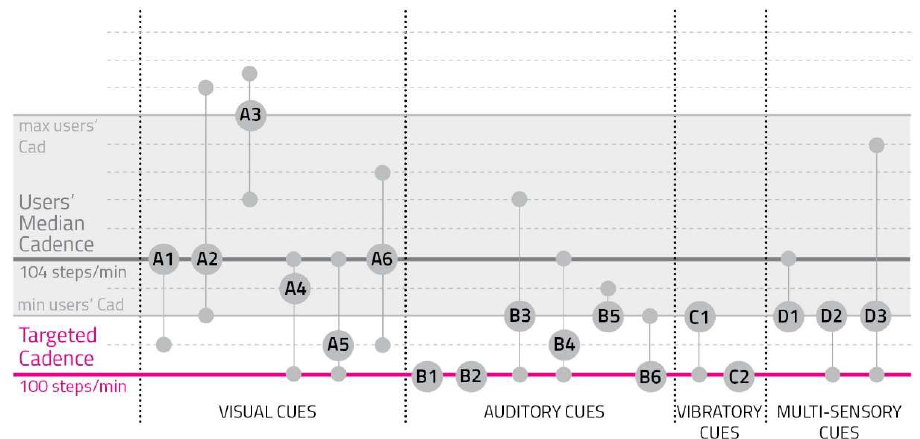
Figure 4. Users’ cadence during each signal. The gray section represents users’ cadences from the minimum to the maximum one. The gray bold line represents users’ median cadence, while the pink one stands for the targeted cadence. Every cue prototype corresponds to the vertical line connecting three circles: the one on the lower part of the line represents the user with the lower difference between the targeted cadence and the one shown during the test; the second circle is bigger and shows the cue code, standing for the average user’s cadence; the upper small circle indicates the user with the biggest difference between the targeted cadence and the one performed during the test.